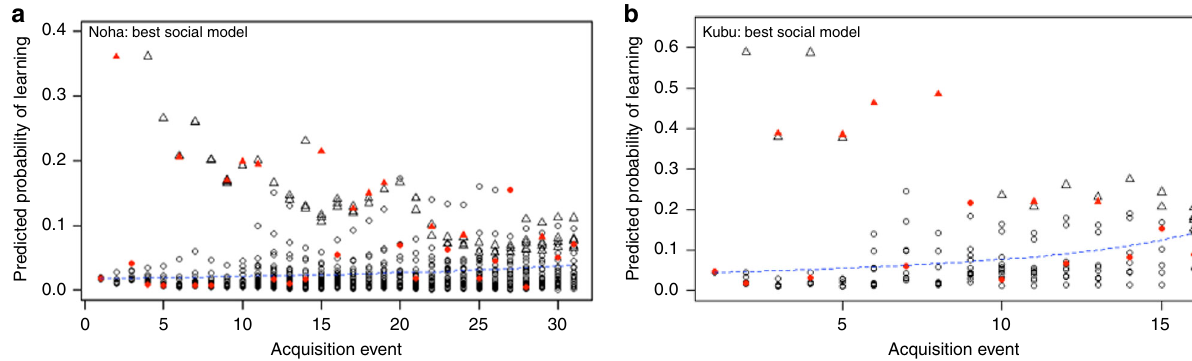
Fig. 3 Predicted probability for learning in each group. a NH group and b KB group. Each point is an individual x option combination. Triangles represent individuals who have already learned one option. Individuals who learned the task are in red. The blue line represents the average probability of learning across all individuals. The better the model fi t, the more red points are above the blue line. Note that triangles tend to be plotted at a high probability, this means that an individual who has learned one option is more likely to learn the other option regardless its observational experience.